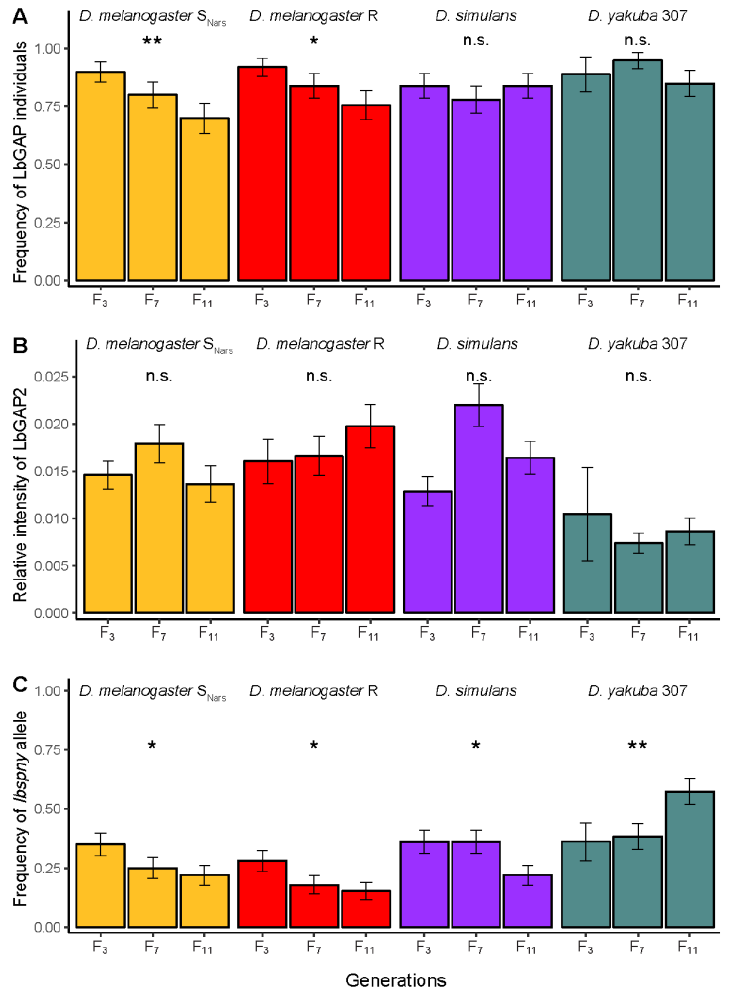
Figure 5. Specific analysis of the evolution of LbGAP, LbGAP2 and LbSPN proteins of parasitoids selected on D. melanogaster S Nasr (in yellow), D. melanogaster R (in red), D. simulans (in purple) and D. yakuba 307 (in grey-green). A. Evolution of the frequency of individuals harbouring a high quantity of the LbGAP protein. B. Evolution of the LbGAP2 protein amount, relative to the total amount of proteins in the venom samples. C. Evolution of the frequency of the lbspny